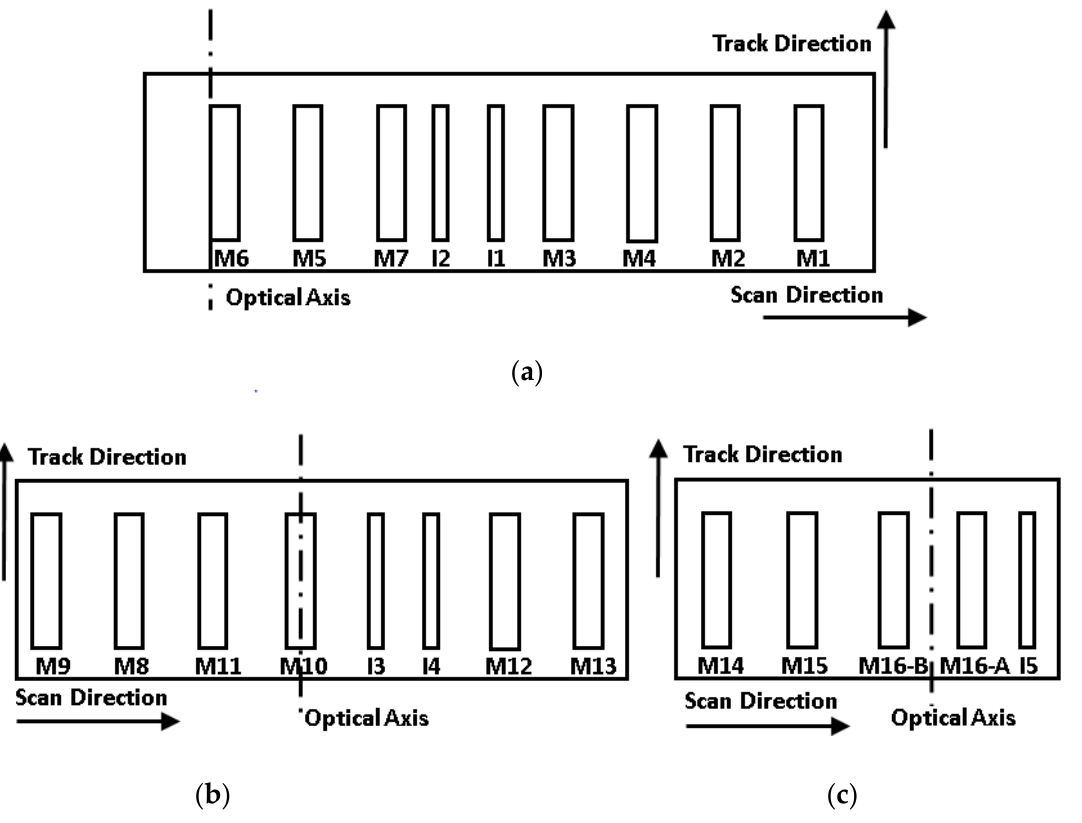
Figure 1. VIIRS band layout on ( a ) VIS/NIR, ( b ) short-wave and mid-wave infrared (S/MWIR) and ( c ) long-wave infrared (LWIR) focal plane assemblies (FPA) [2].